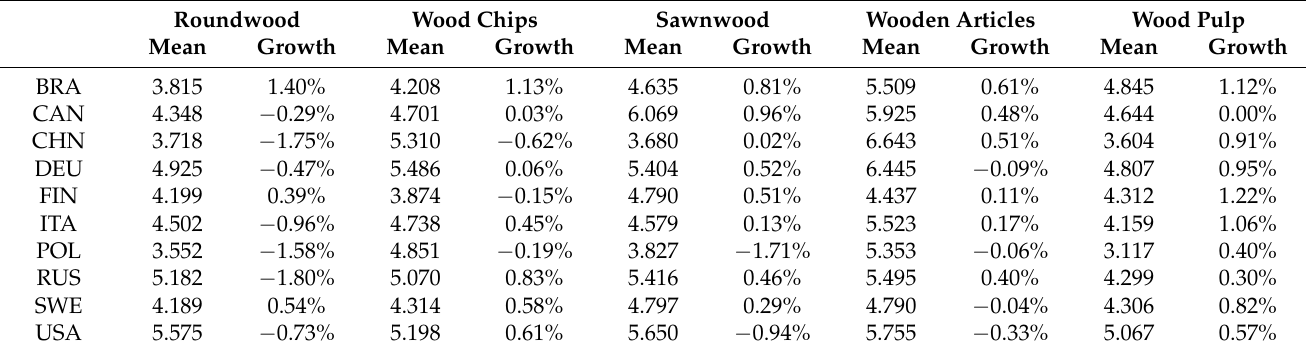
Table 7. Annual average values and annual growth rates of international competitiveness for other forest products in the observed countries from 2012 to